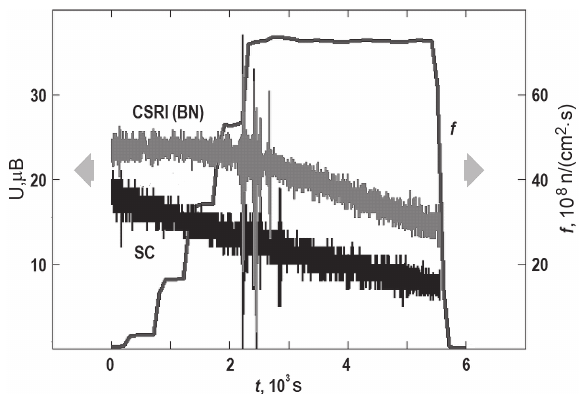
Figure 1. Intensity of neutrons, f , and difference of potentials, U , for a supercapacitor (SC) and a CSRI mockup in the process of